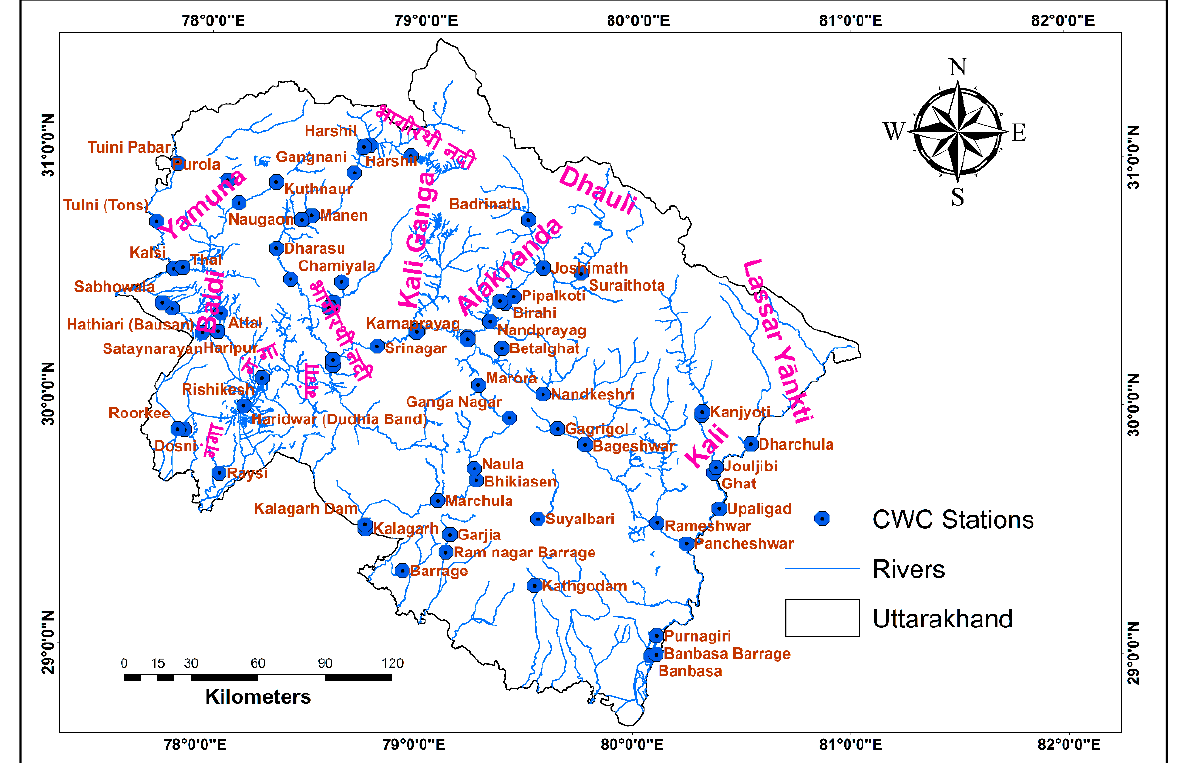
Figure 12. The locations of various river monitoring stations of the Central Water Commission.